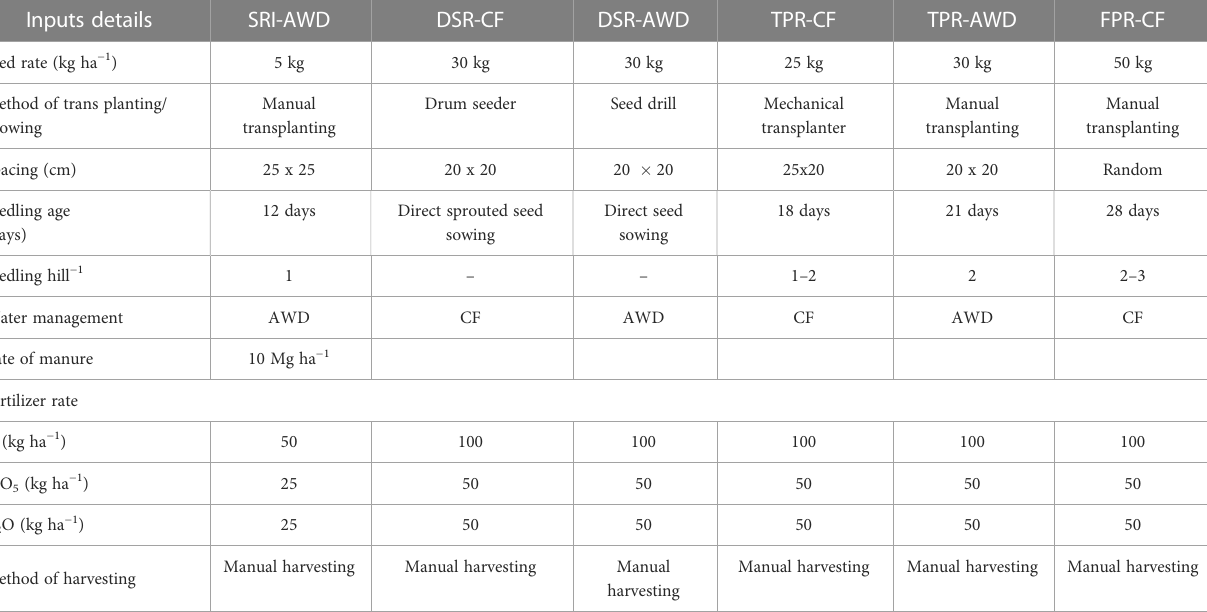
TABLE 1 Details description of different rice production